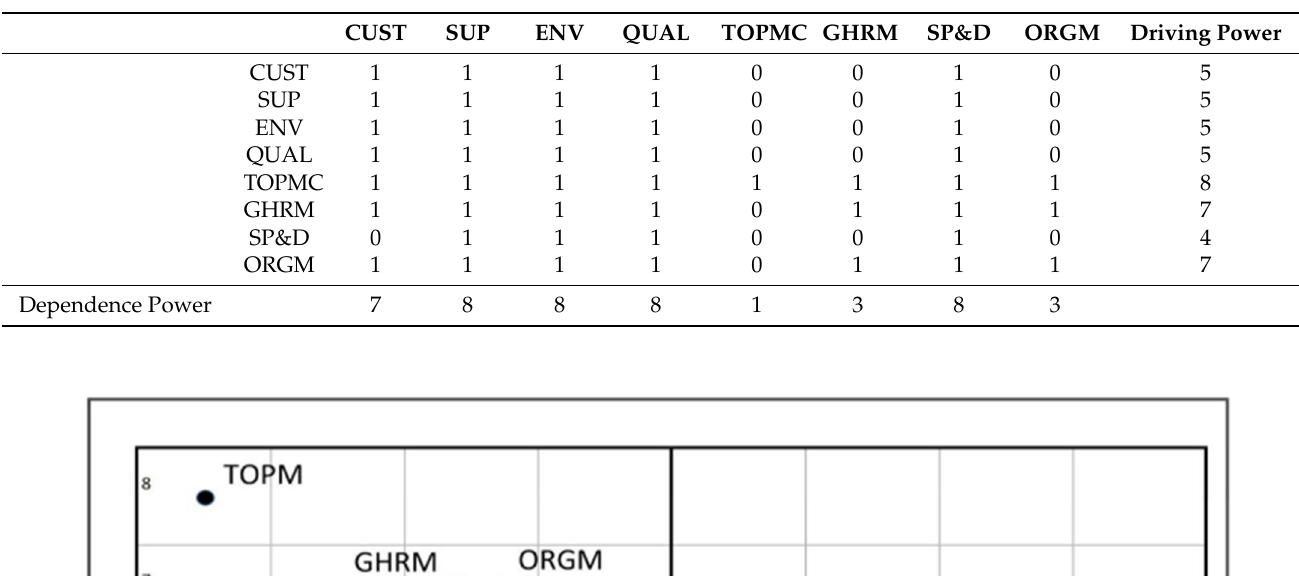
Table 7. Computed driving power and dependence power for each green supply chain management practice.